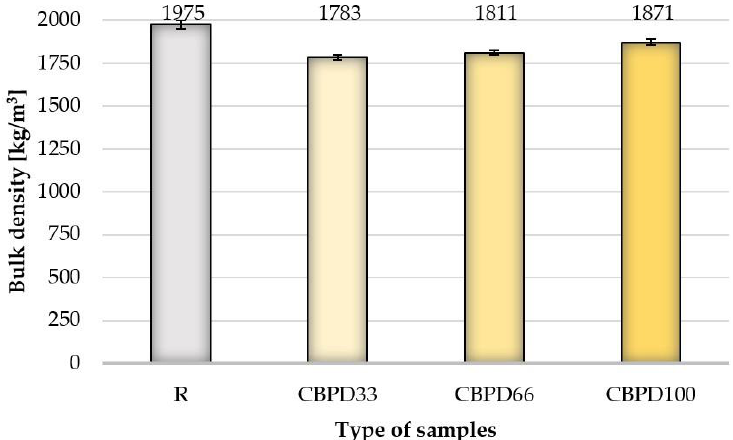
Figure 5. Bulk density results.